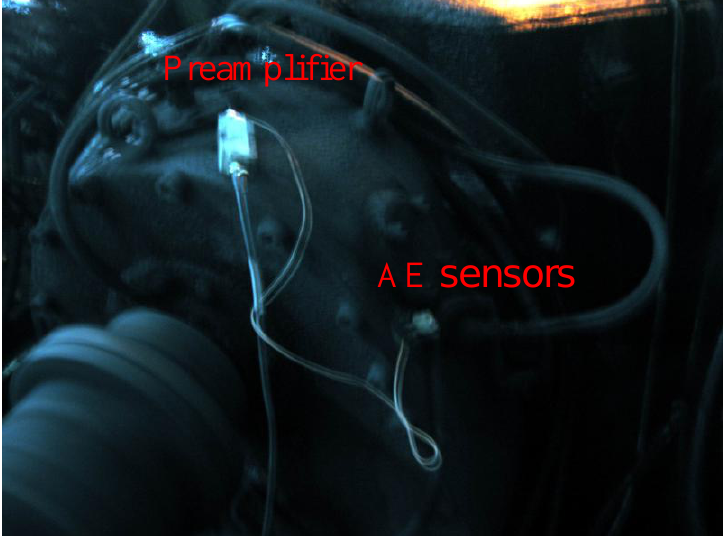
Figure 6. Installation site of